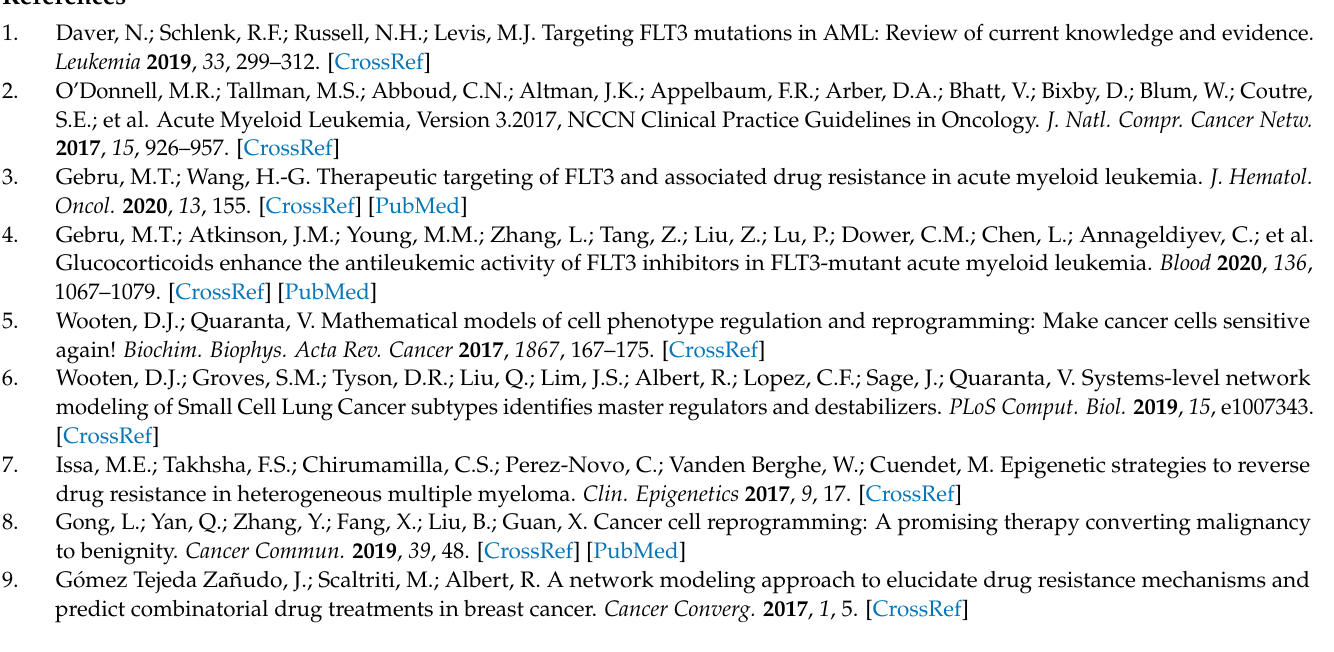
Figure S3: Blue module enrichment, Figure S4: Brown module enrichment, Figure S5: Green module enrichment, Figure S6: Red module enrichment, Figure S7: Turquoise module enrichment, Figure S8: Yellow module enrichment, Figure S9: Network construction, Figure S10: Full network, File